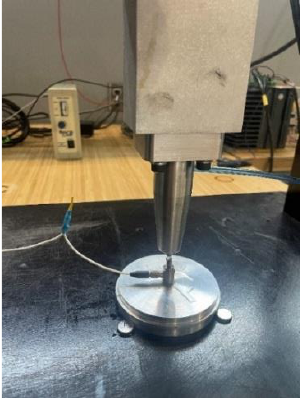
Figure 7. Close-up of force transducer and jet injector nozzle.